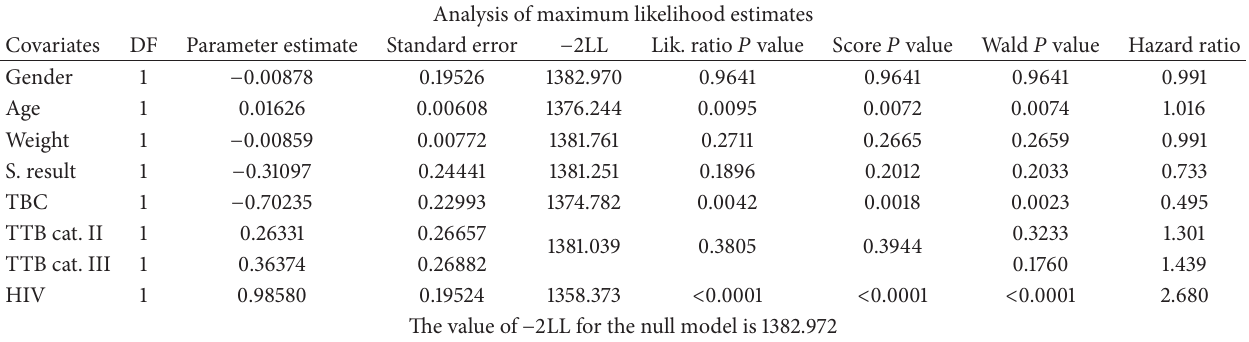
Table 4: Results of the univariable proportional hazards Cox regression model of TB patients DOTS in six randomly selected AA health